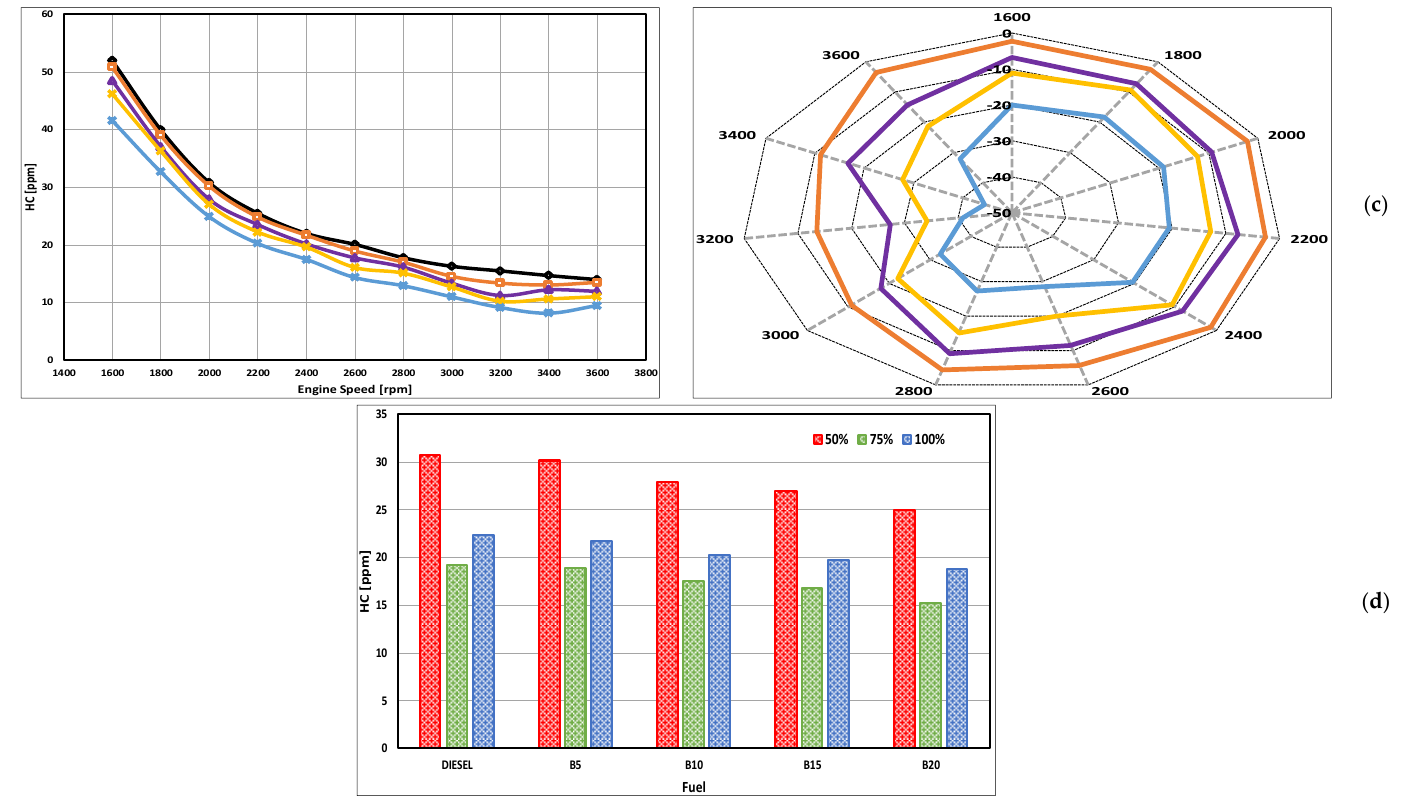
Figure 7. HC variations with engine speed and load, presented as trends (left) and the normalized value contours (right) for ( a ) 100%, ( b ) 75%, and ( c ) 50% loading. ( d ) Comparison of the results for all fuels at all loads at 2000 rpm.